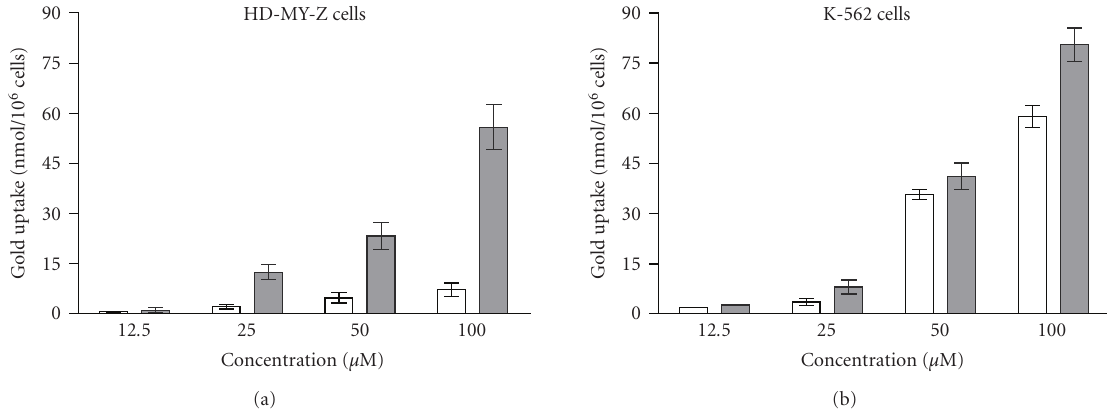
Figure 5: Intracellular accumulation of gold following [Au(II)Hp columns) or 60 minutes (gray columns), means of 4 independent